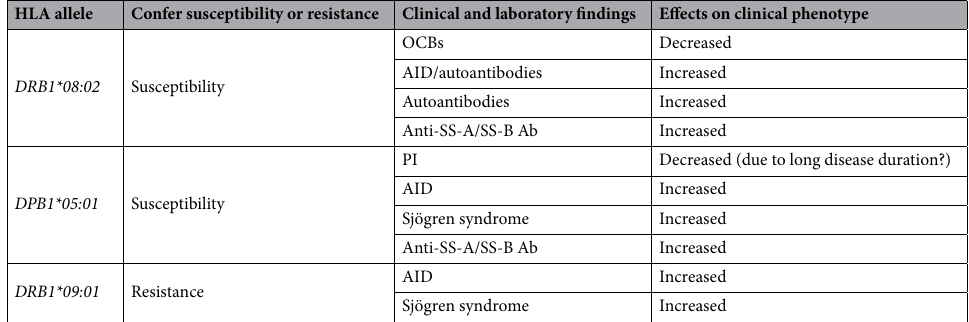
involvement less frequently and had a lower FS score of sensory function than non-carriers ( p = 0.022 and 0.048, respectively). HLA-DRB1*09:01 -positive MS patients had lower ARR and FS scores of bowel and bladder function and had brainstem involvement less frequently than DRB1*09:01 -negative patients ( p = 0.047, 0.015 and 0.005, respectively) (Supplementary Table S8). EDSS scores, PI and MSSS were not different between these two groups. MS patients with HLA-DRB1*13:02 tended to have brainstem and spinal cord involvement less frequently than those without the allele ( p = 0.055 and 0.058, respectively). Moreover, HLA-DRB1*13:02 -carriers had a lower